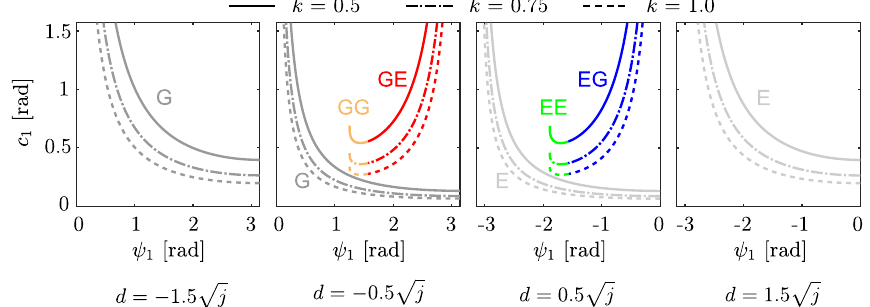
Figure 5. Relationships between ψ 1 and c 1 for periodic solutions with various values of k and d in the model. The solution type depends little on k , but substantially depends on d